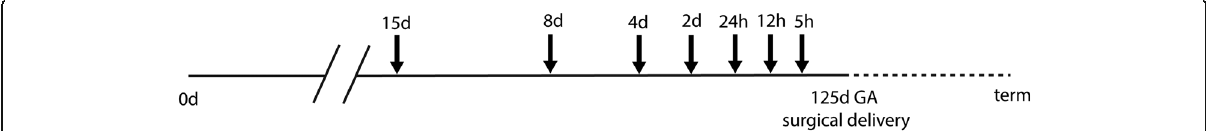
Fig. 1 Study design. Pregnant ewes received an IA injection with 10 mg LPS at 5, 12, or 24 h or 2, 4, 8 or 15 days (black arrows) before preterm delivery at 122 days of gestation (term ~ 150 days). Control animals received an IA saline injection at comparable time points to LPS injections. Timing shown in gestational